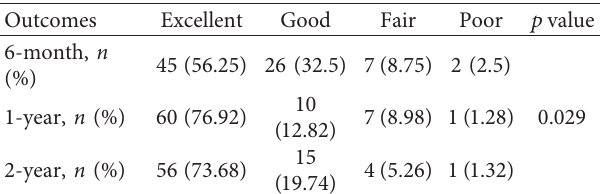
Table 2: The outcomes of modified MacNab evaluation at